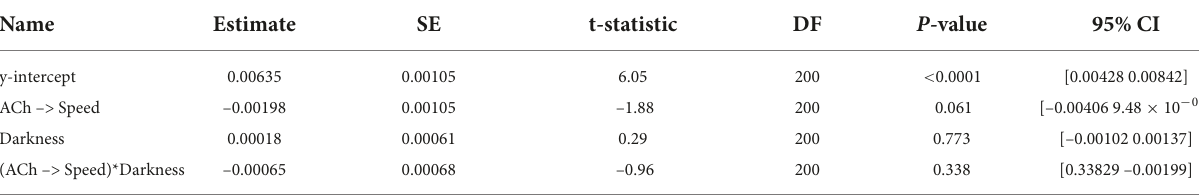
TABLE 5 Results of a linear mixed-effects model of Granger causality between the logarithm of movement speed (Speed) and the z-scored (cid:49) F/F of cholinergic activity (ACh) with four fixed effects, namely the y-intercept, the Granger causality magnitude with two levels of direction, namely from the logarithm of movement speed to cholinergic activity (Speed → ACh) and from cholinergic activity to the logarithm of movement speed (ACh → Speed), lighting condition with two levels, namely light and darkness, and the interaction between direction in Granger causality and lighting